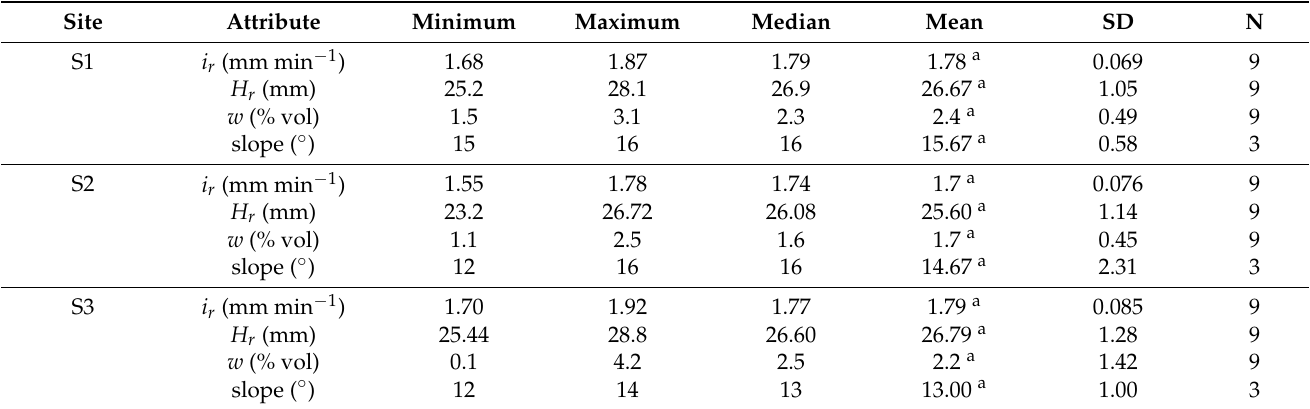
Properties denoted with different letters are significantly different on significance level